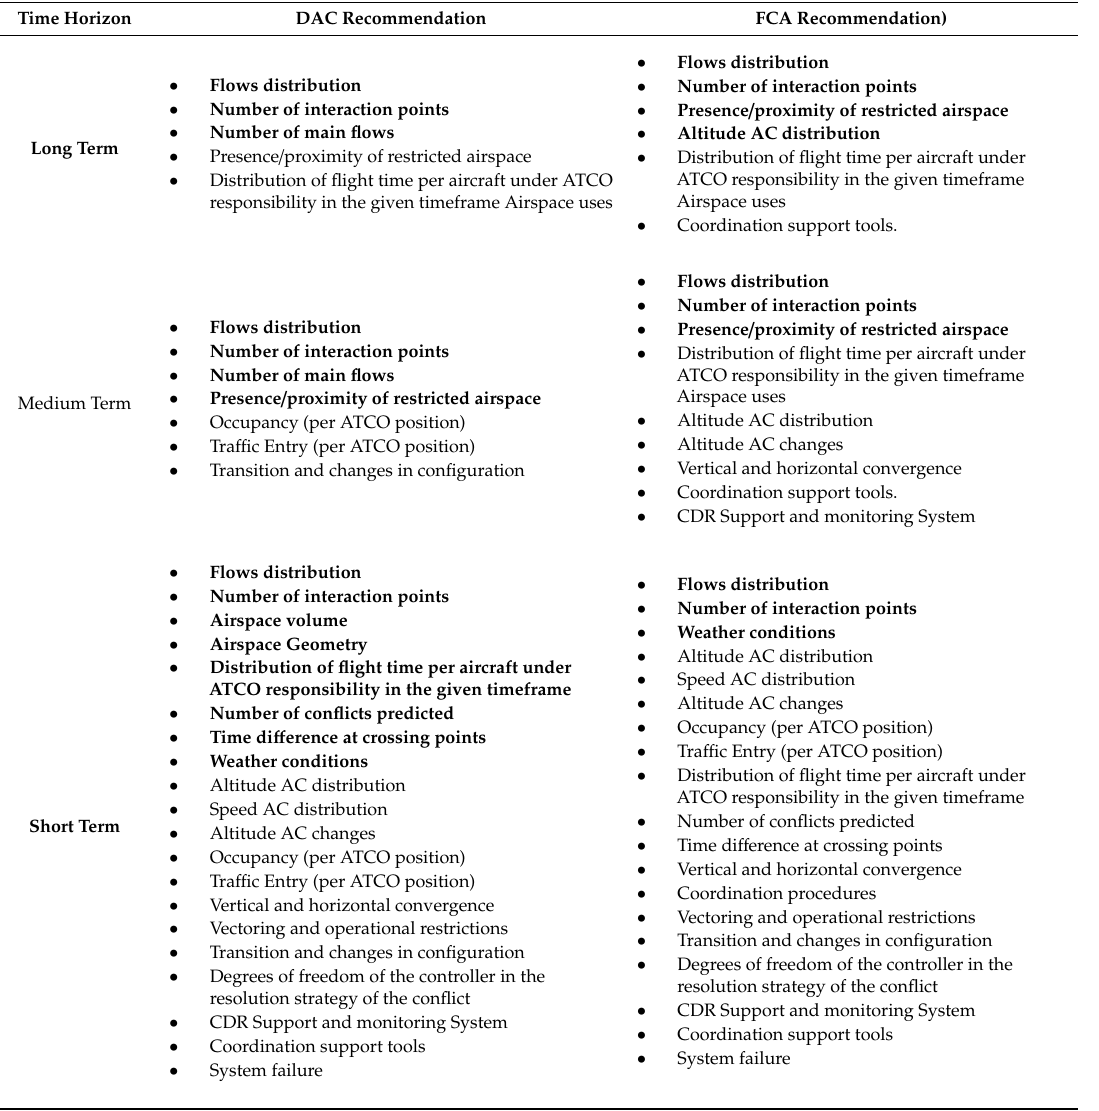
Table 7. Complexity Generators (CGs) recommended as inputs in the complexity metrics and algorithms for each application and time horizon. CGs in bold black requires further reduction in